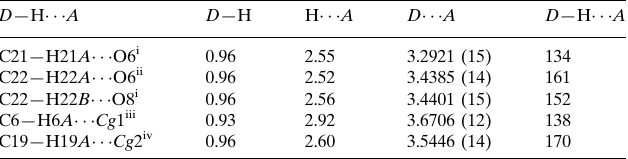
Hydrogen-bond geometry (A˚ , (cid:2)